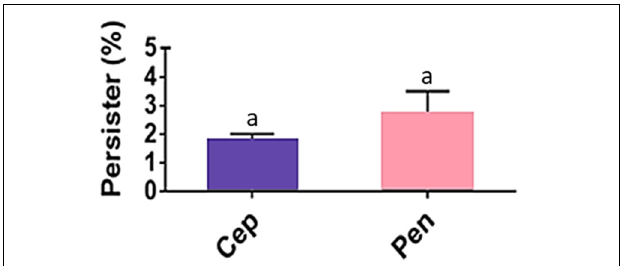
FIGURE 1 | Streptococcus pyogenes persisters recovered from biofilm-like environments at concentrations of 4 µ g/mL cephalexin (Cep; MIC = 0.5 µ g/mL) or 8 µ g/mL penicillin (Pen; MIC = 0.01 µ g/mL). The average CFU/mL of the control cells (no antibiotic) was 6.0 × 10 10 and corresponded to 100%. One way ANOVA ( p < 0.001; F = 16.81; DF total = 11) was applied for CFU values. Post hoc Tukey’s test was performed followed ANOVA for multiple comparisons between the control and antibiotics ( a p < 0.01) and between antibiotics (there was no significant difference in the amount of persister cells recovered when Cep and Pen were compared; p =